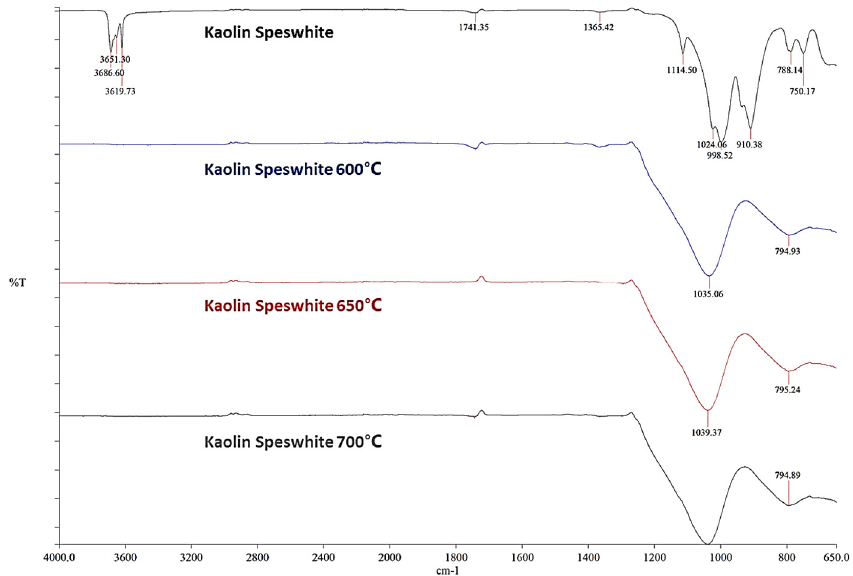
Figure 7. FTIR spectra of Kaolin Speswhite and its calcined products at 600, 650 and 700 °C.